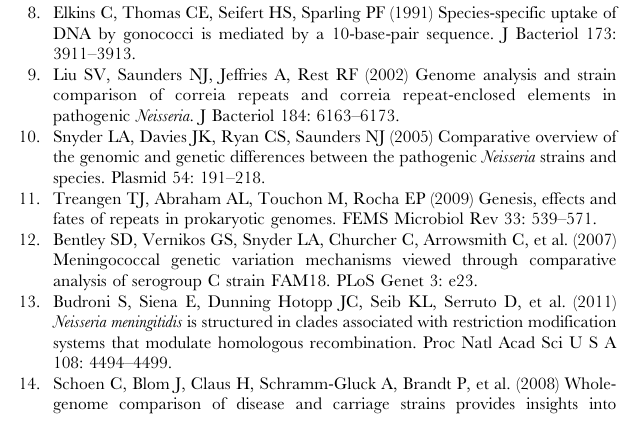
Table S13 ssDNA prophage NGO F 9 in N. gonorrhoeae